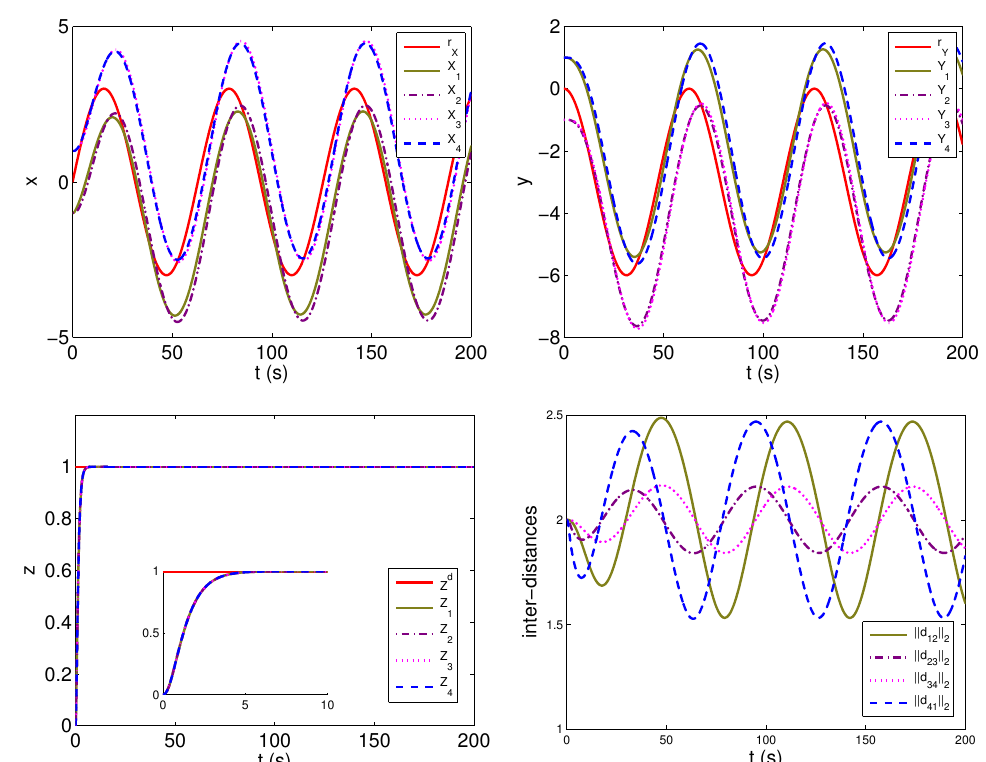
Figure 2. Rigid formation of 4 quadrotors without high-order derivatives estimation, the objective is to track the RFT r ( t ) and meanwhile keep inter-distance between quadrotors.